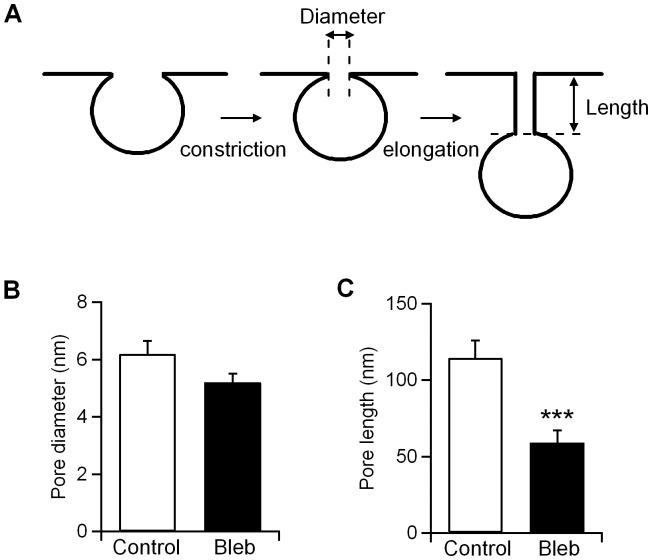
Blebbistatin affects fission pore geometry.A good model for explaining the dynamics of the fission pore is to assume that a decrease in pore diameter occurs initially (first phase) and is followed by a lengthening of the fission pore (second phase) (A) [28]. Assuming that successive steps of narrowing and lengthening explain the observed changes in pore resistance, we have calculated the final pore diameter (Dp final) and length (Lp final). No significant differences were found in the final pore diameter between control and blebbistatin-treated cells (B). However, NM-2 inhibition reduced pore length (C). All error bars represent the S.E.M. ***p<0.001.